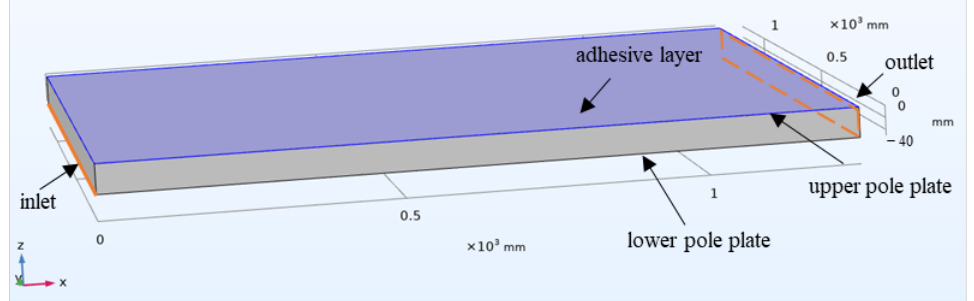
Figure 4. 3D model of the mechanical model.